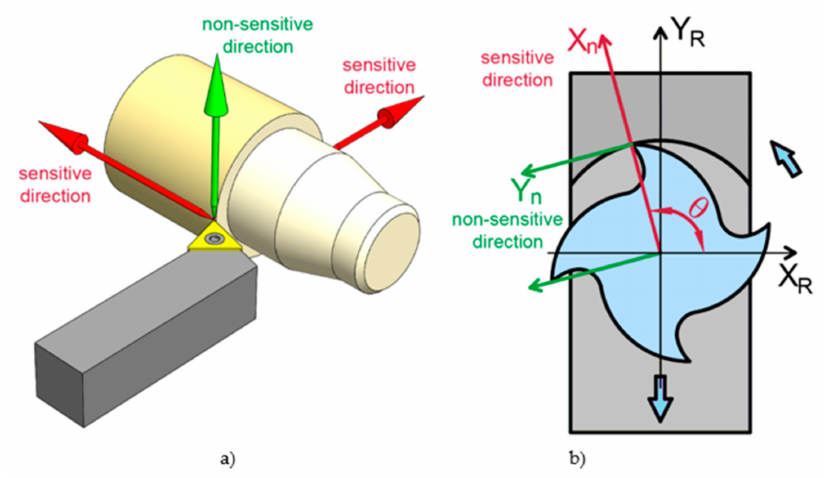
Figure 3. Sensitive directions for: ( a ) turning and ( b ) face